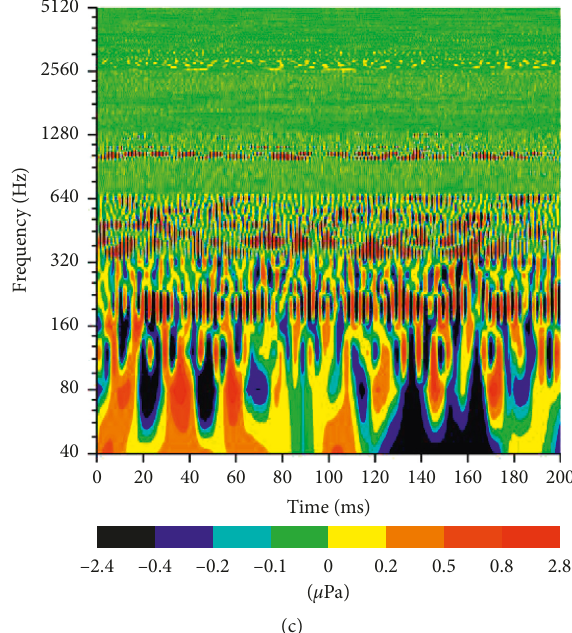
Figure 6: Time-frequency domain diagram of cavitation noise at rated flow rate: (a) noncavitation stage σ stage σ 0.021; (c) severe cavitation stage σ (cid:28)